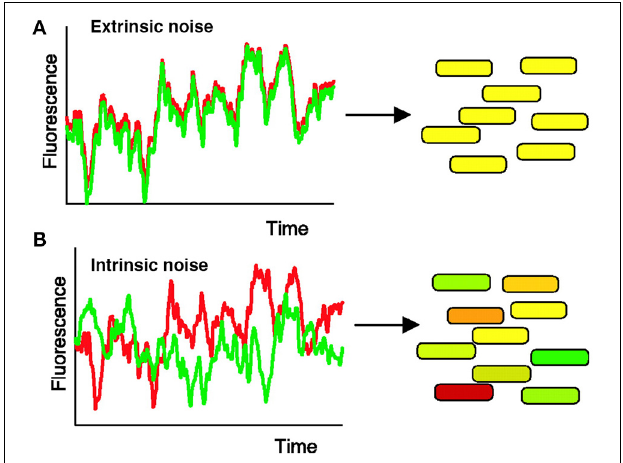
FIGURE 2 | Measuring intrinsic and extrinsic noise in E. coli . Intrinsic noise can be differentiated from extrinsic noise by measuring the activity of two allelic GFP variants, YFP (shown in red) and CFP (shown in green), under control of the same promoter. (A) When intrinsic noise is absent within a single cell, the fluorescence intensity of YFP and CFP should be identical (represented by yellow cells). Extrinsic noise will cause different cells within the population to exhibit variations in overall fluorescent intensity. (B) Intrinsic noise within a single cell will cause the fluorescence intensity of YFP and CFP to differ, resulting in some green and some red tinted cells. Reproduced from Elowitz et al. (2002). Reprinted with permission from